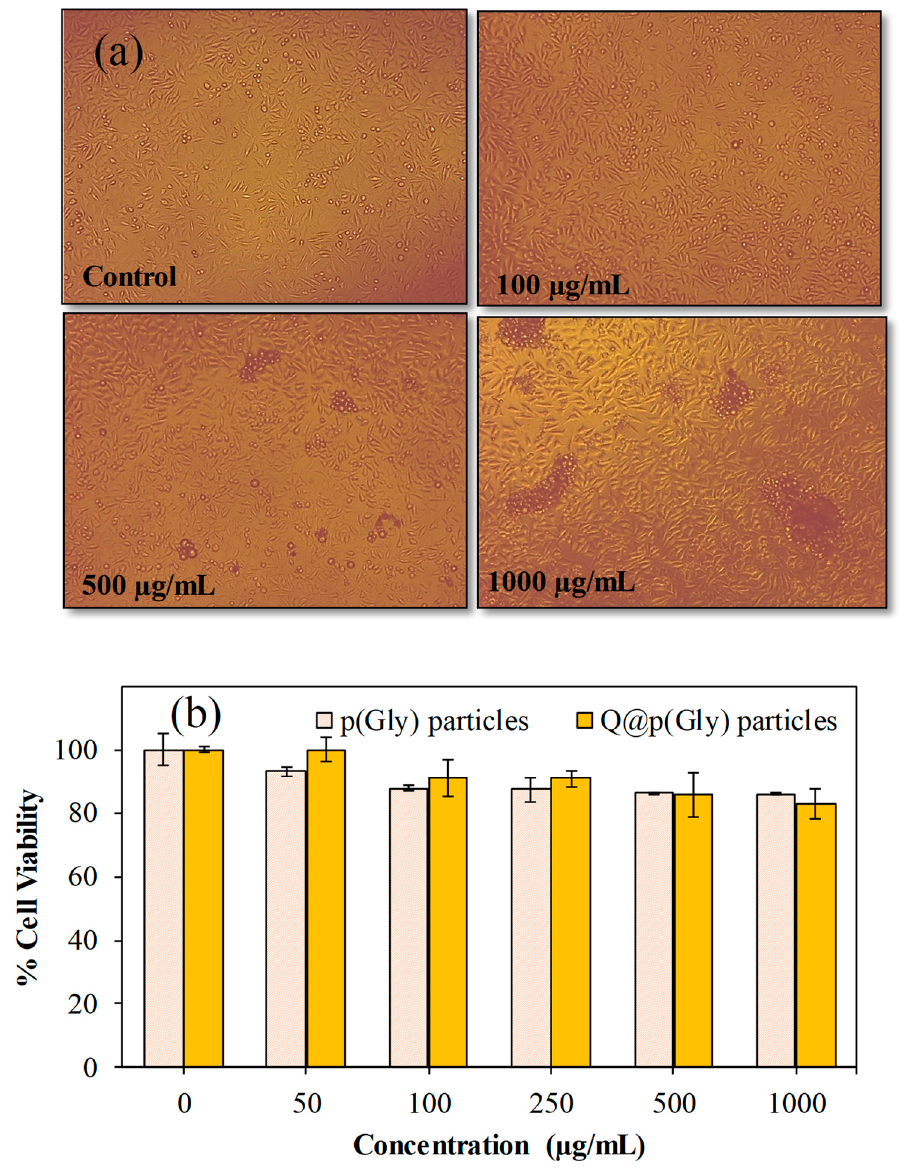
Figure 5. ( a ) Optic microscope images of L929 fibroblasts as control groups and p(Gly) particles at 100, 500 and 1000 µg/mL concentrations, and ( b ) Cytotoxicity of p(Gly) and Q@p(Gly) particles on L929 fibroblasts at 24 h incubation time.